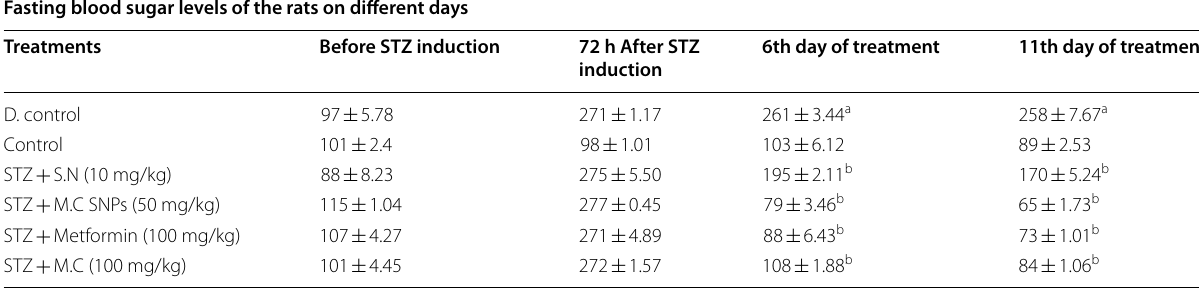
a Statistical difference to control ( p < 0.05) while b statistical difference to Diabetic control ( p < 0.05). Results are expressed in mean